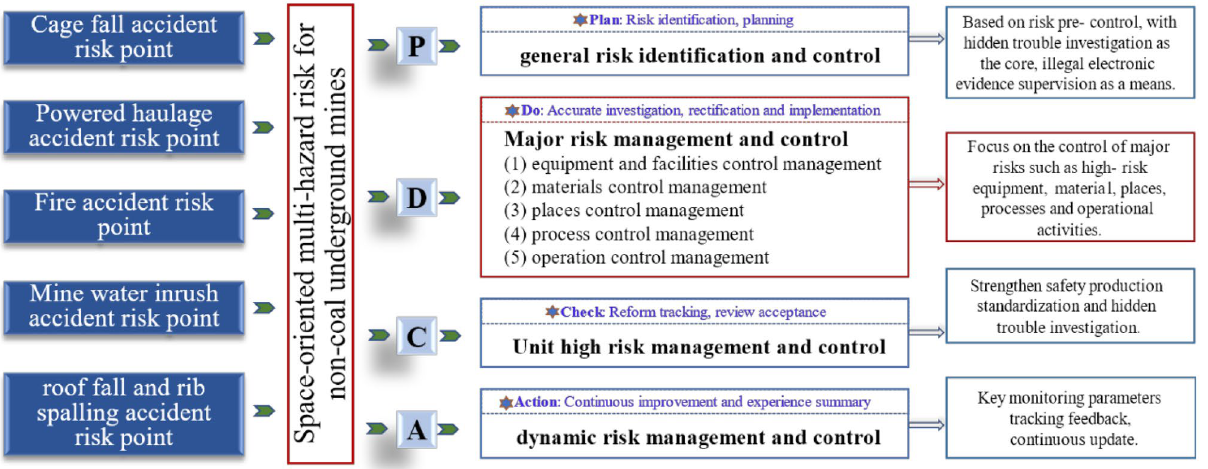
Figure 6. ’PDCA’ closed-loop control model for multi-hazard risk in non-coal underground